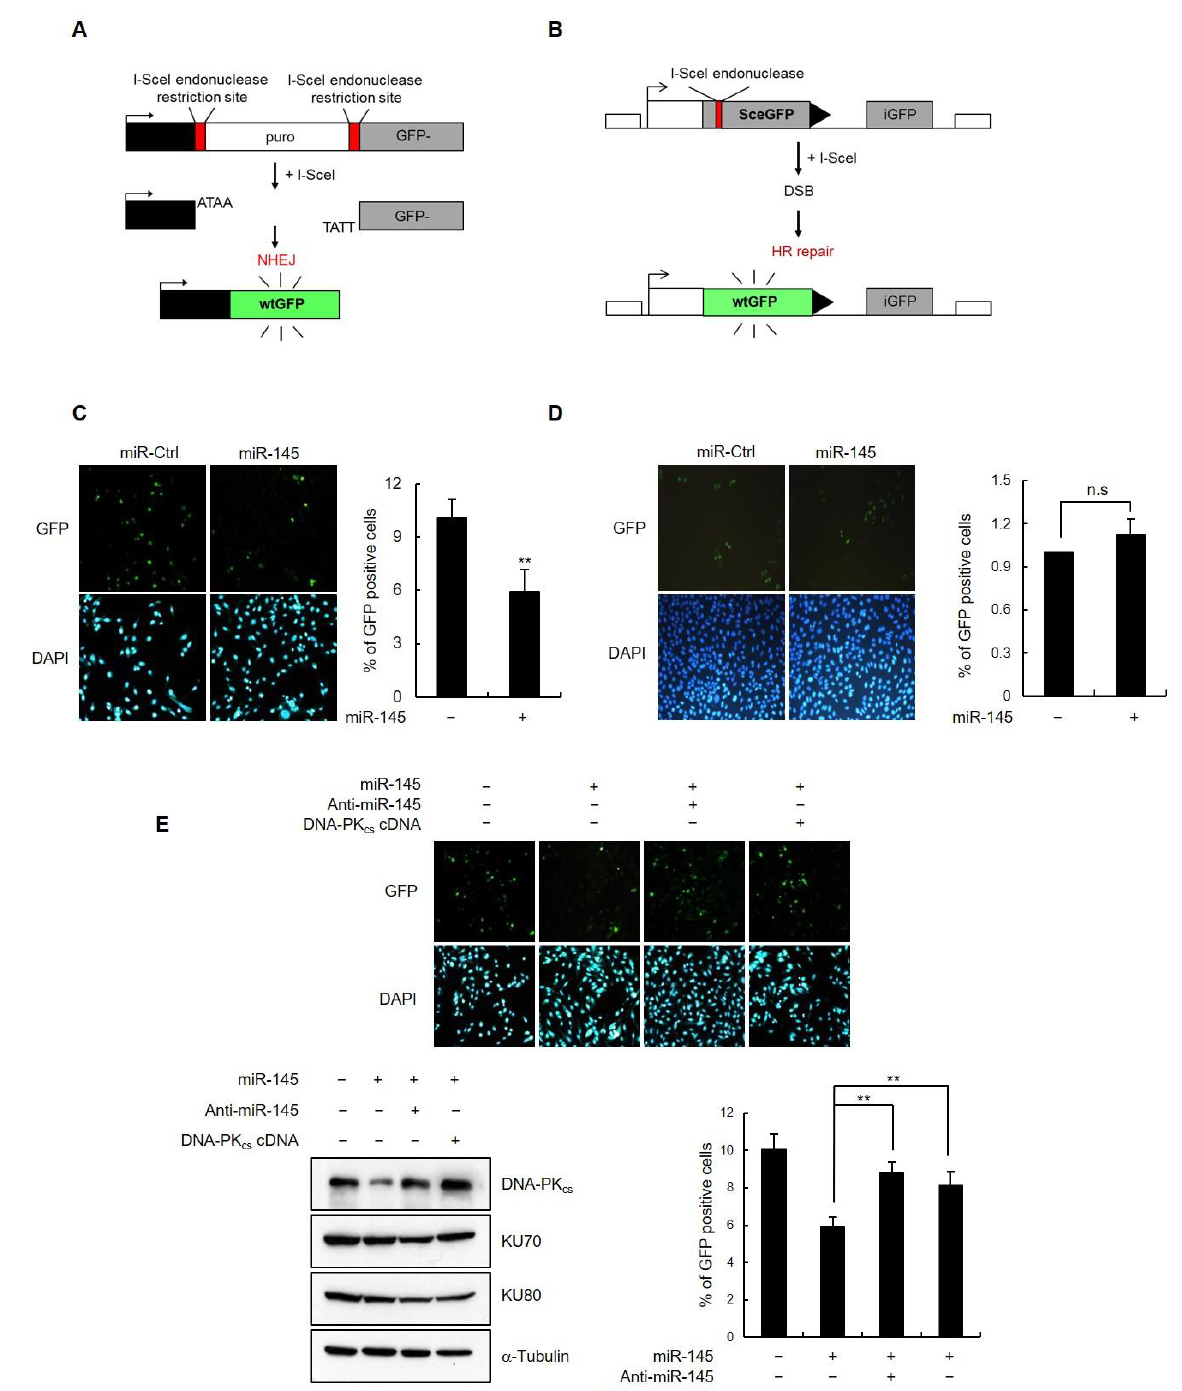
Figure 5. miR-145 affects NHEJ activity. ( A , B ) Schematic representation of fluorescence-based NHEJ ( A ) and HR ( B ) assay system using HeLa-EJ5 cells and U2OS-DR-GFP cells, respectively. ( C , D ) Cells were transfected with either miR-145 or a control miRNA, followed by transfection with the I-SceI vector. Functional NHEJ ( C ) and HR ( D ) result in GFP-positive cells. The percentage of GFP-positive cells was visualized under a microscope (left) and cells were collected using flow cytometry (right). Results are shown as the mean ± SD ( n = 3); **, p < 0.01. n.s. indicated not statistically significant. ( E ) HeLa-EJ5 cells were co-transfected with miR-145, a control miRNA, anti-miR-145, or DNA-PK cs cDNA in combinations as indicated. After transfection with the I-SceI vector, the cells were analyzed using flow cytometry for efficacy of GFP expression. Results are shown as the mean ± SD ( n = 3); **, p < 0.01.